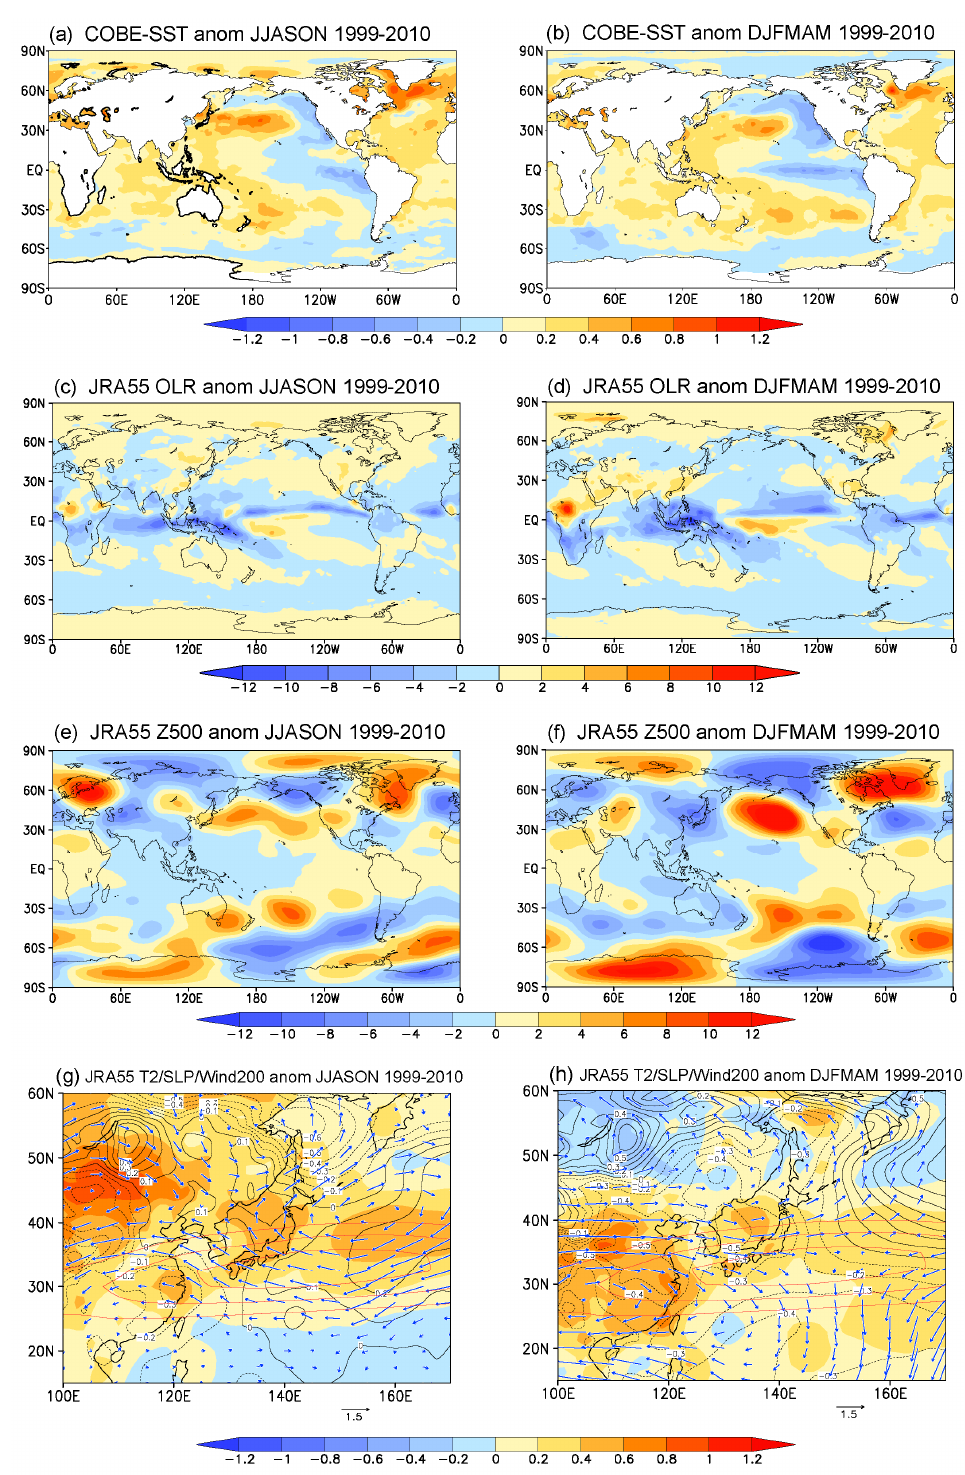
Figure 2. Observed anomalies averaged from 1999 to 2010 for DJFMAM (left) and JJASON (right). ( a , b ) sea surface temperature (SST) (K), ( c , d ) outgoing longwave radiation (OLR) (W/m 2 ), ( e , f ) Z500 (m, zonal mean is removed), ( g , h ) surface air temperature (shading, K), sea level pressure (SLP; contours, hPa), and 200 hPa wind velocity (arrows, m/s). Red contours in ( g , h ) show 50, 60, and 70 m/s of climatological westerly as a reference of a mean position of the Asian Jet. Sea surface temperature (SST) is based on COBE-SST, and atmospheric variables are from JRA-55 reanalysis.